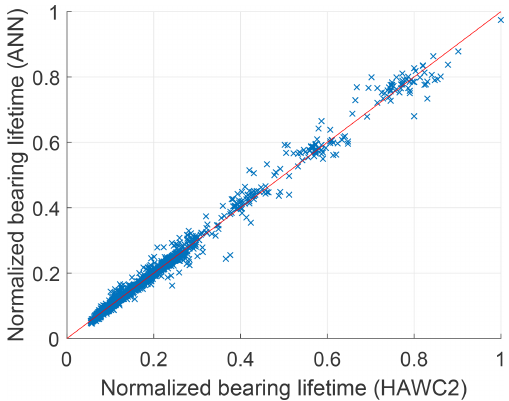
Figure 9. Normalized bearing lifetime L 10 estimated by ANN on test set with respect to normalized bearing lifetime simulated using HAWC2.